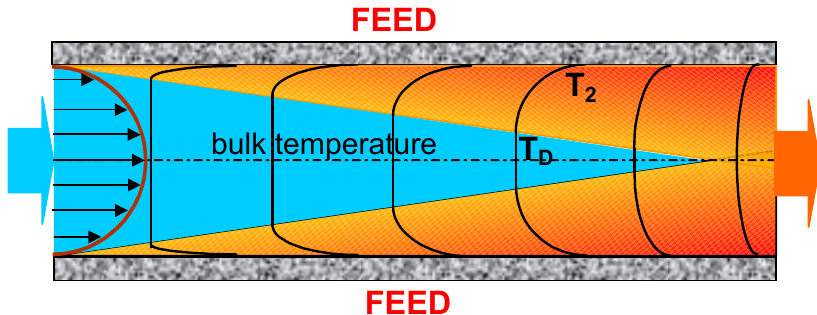
Figure 2. Scheme of distillate temperature changes during distillate flow inside the capillary membrane. T D —distillate temperature.